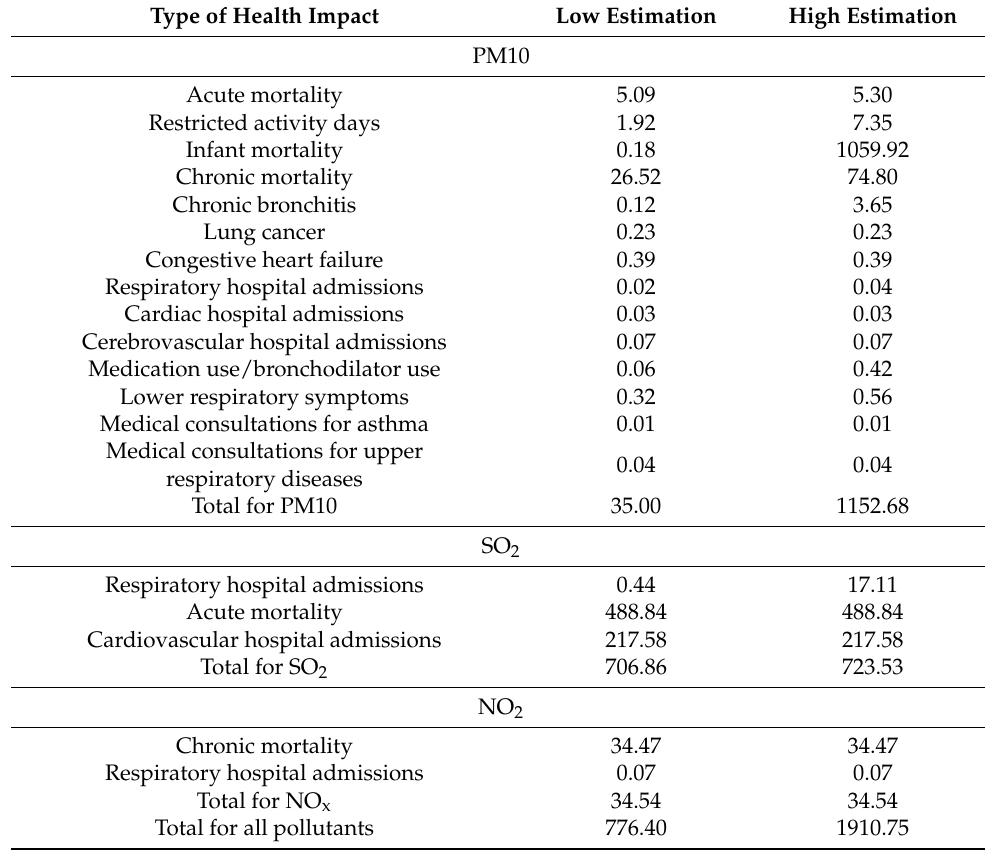
Table 9. External costs associated with the Polish power sector in 2018 (million EUR 2018).